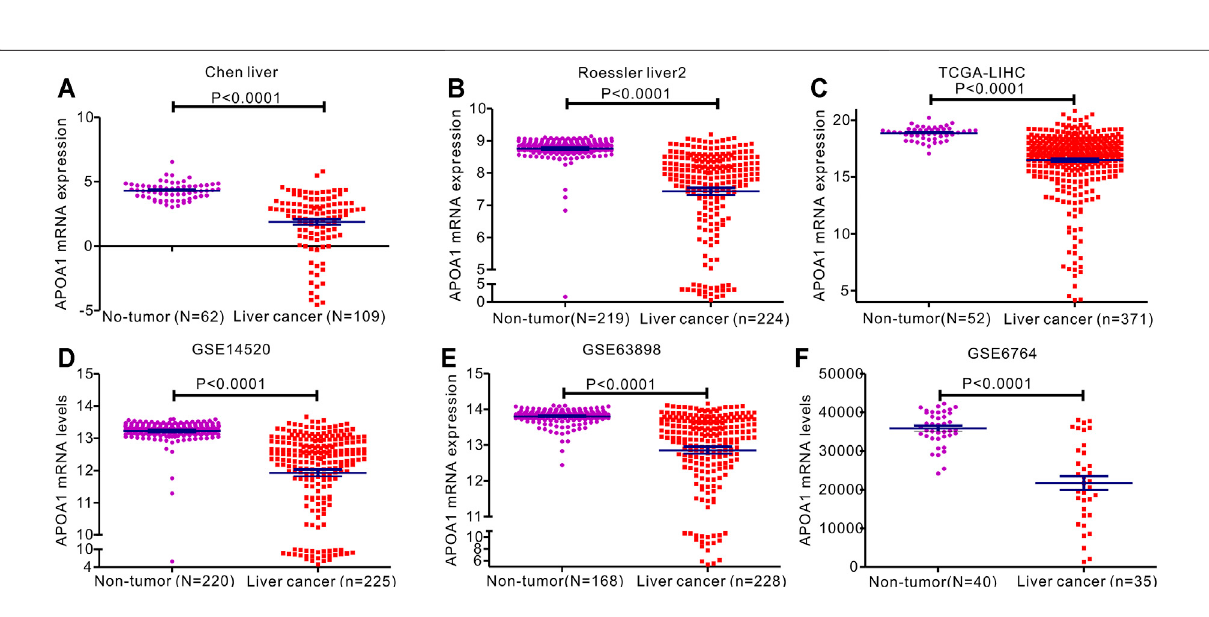
Frontiers in Genetics |